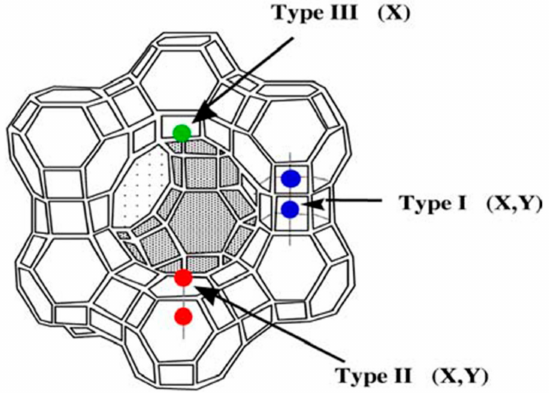
Figure 1. Sodalite and supercages within X and Y zeolites, and the locations of the three types of